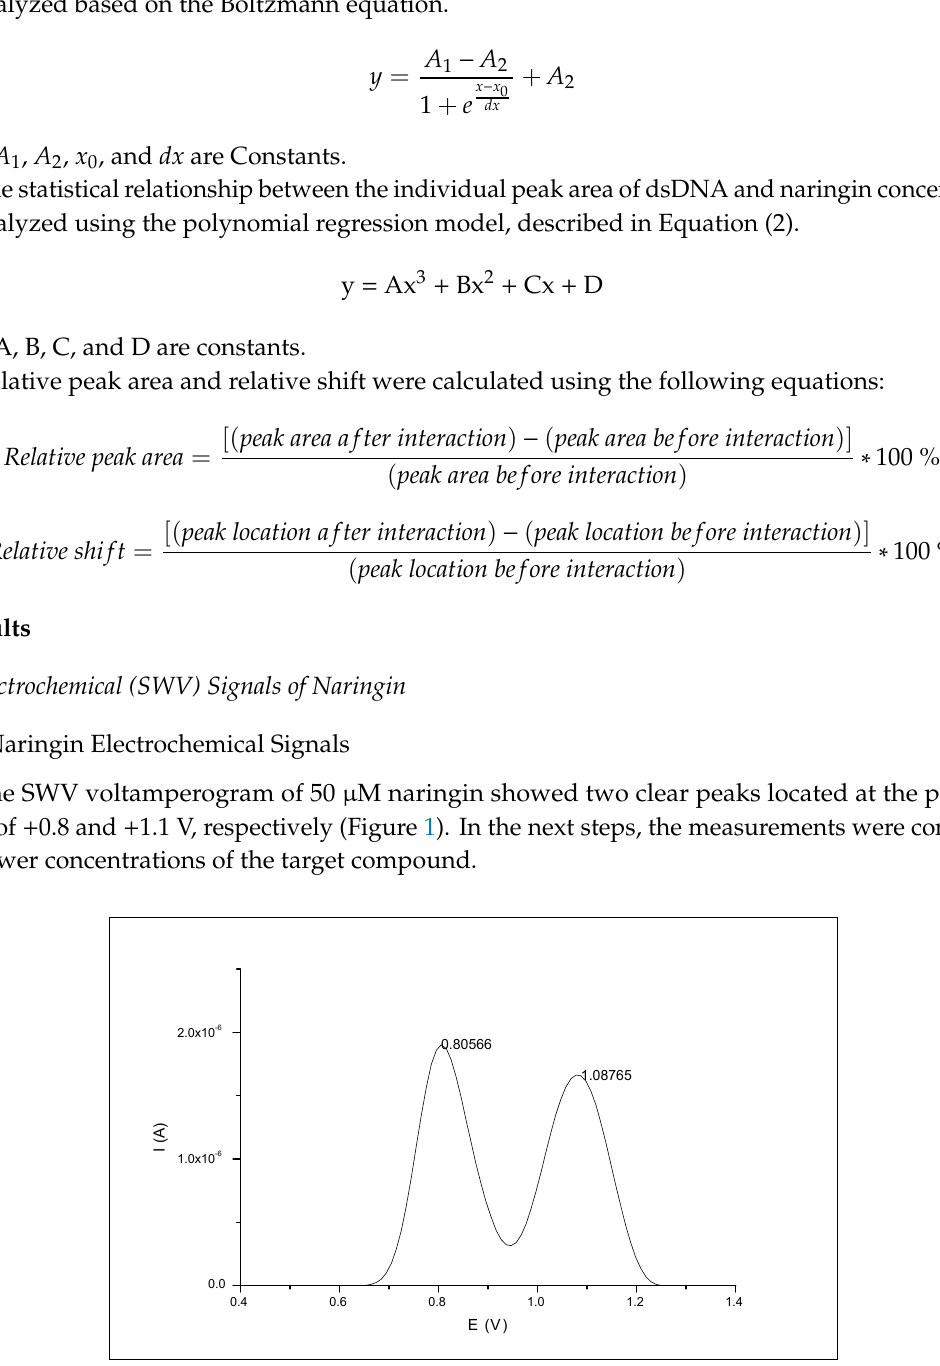
Figure 1. Square-wave voltamperogram of 50 µ M naringin Figure 1. Square‐wave voltamperogram of 50 μM naringin solution.